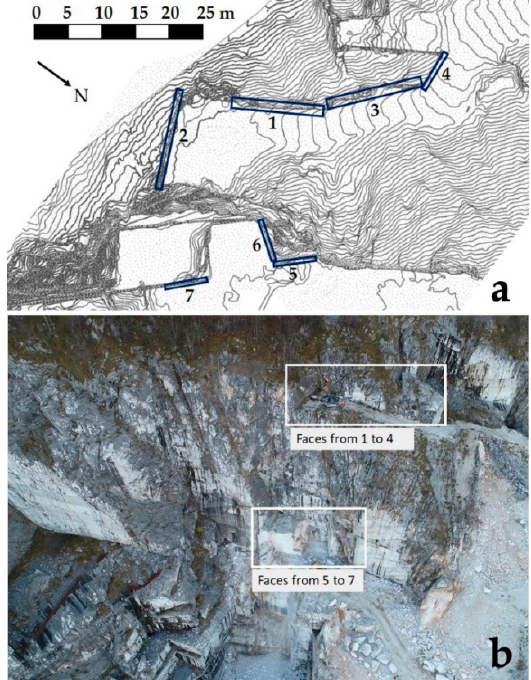
Figure 8. ( a ) Location of the seven surveys along scanlines performed in the quarry; ( b ) image of the quarry showing locations of faces from 1 to 7.